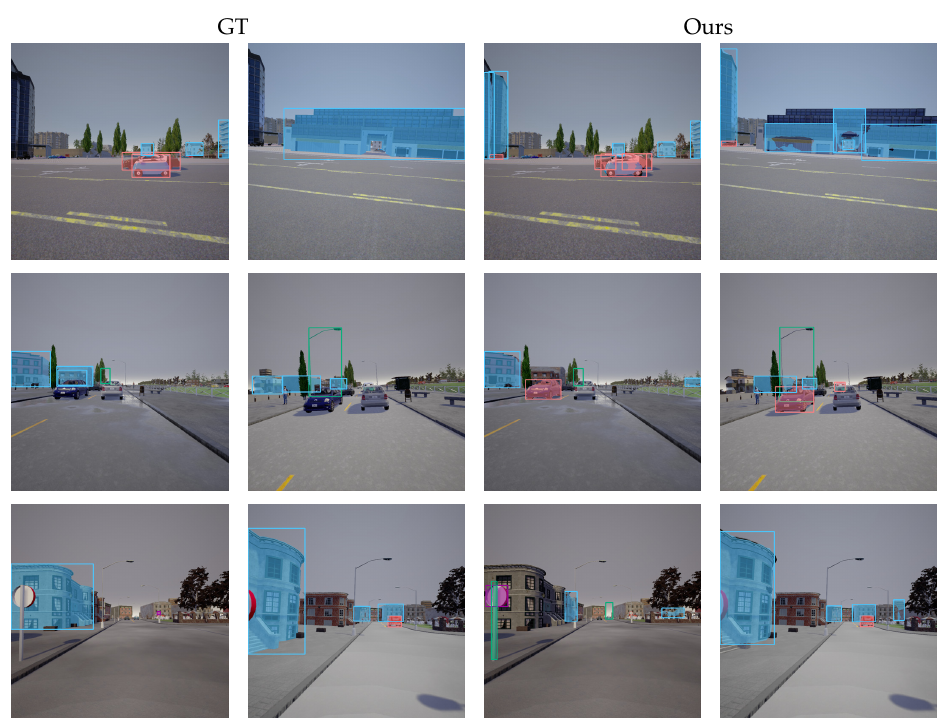
Figure 10. Examples of failures. Object-level changes indicated by color-coded bounding boxes: light blue for buildings, pink for cars, green for poles and purple for traffic signs. The examples in the first and second rows suffered from errors in the object detection module and the graph matching module, respectively. The last row shows the error that was caused by moving an object out of the field of